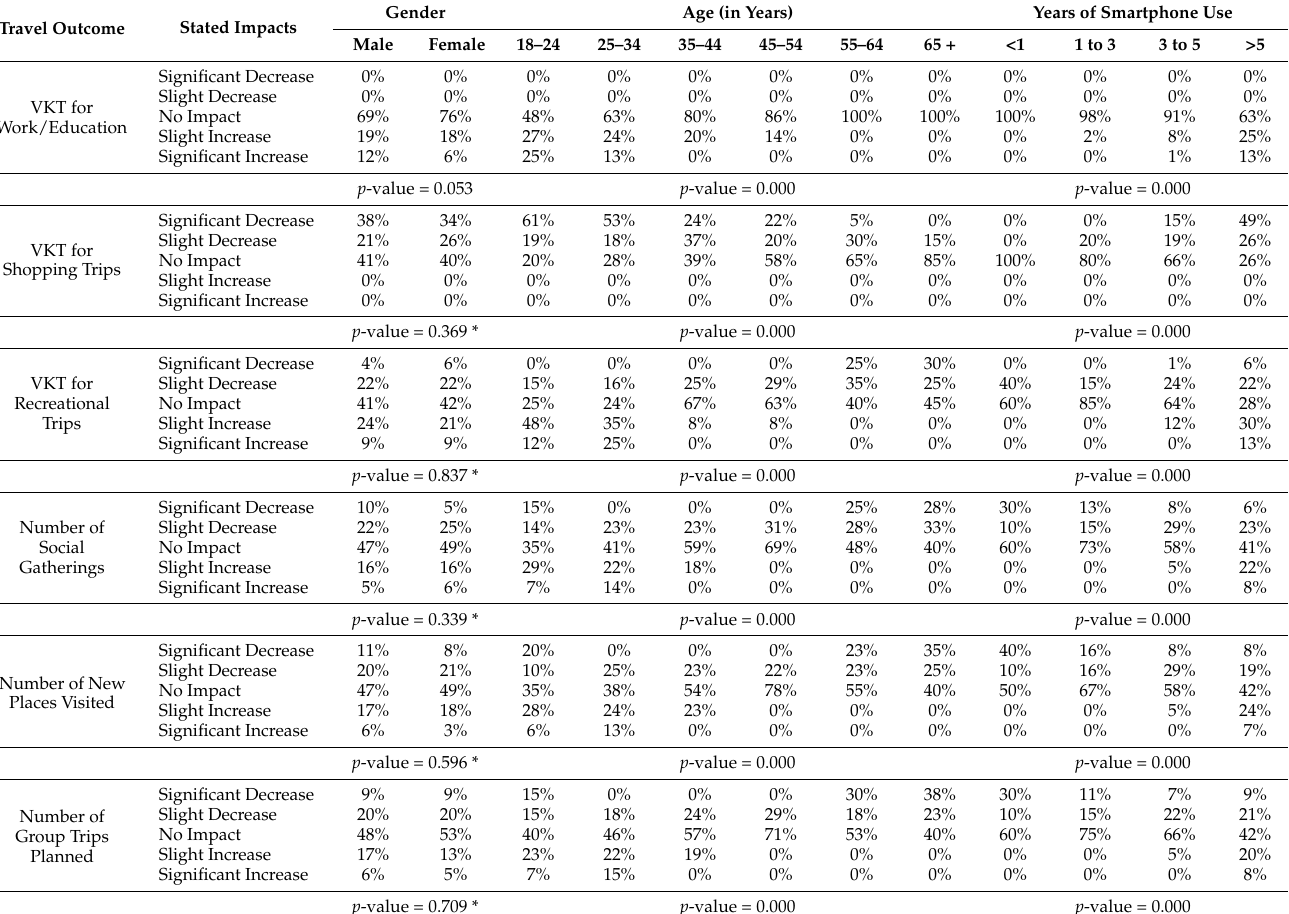
Table 4. Personal level attributes and travel outcome-wise classification of smartphone app